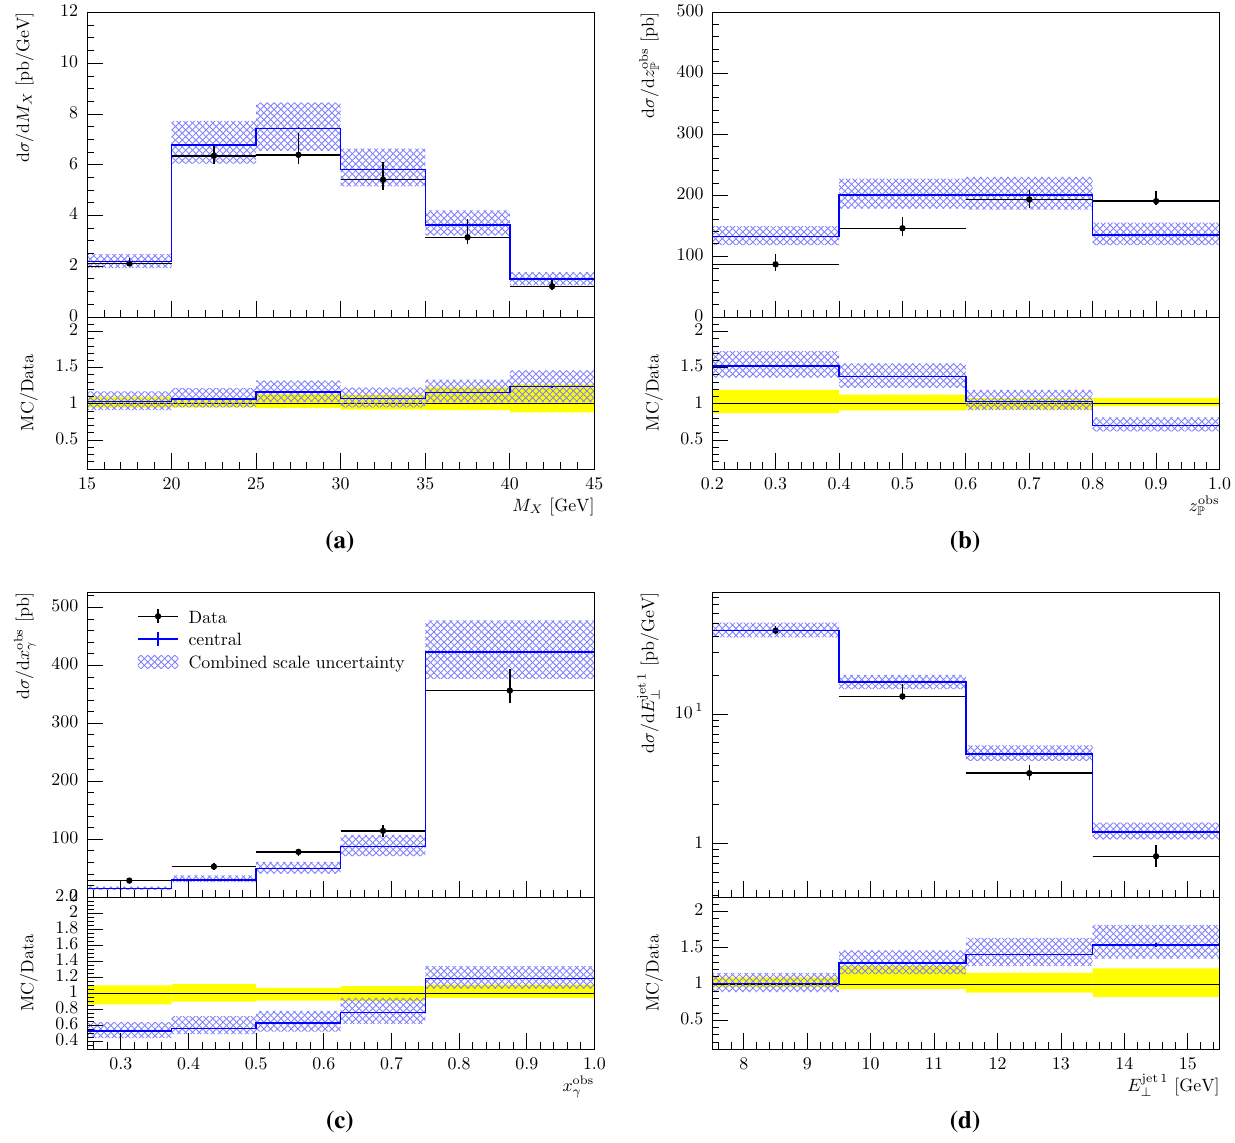
Fig. 9 The model along with the uncertainty bands arising from varying the renormalization- and factorization scales compared to ZEUS data on M X ( a ), z obs P ( b ), x obs γ ( c ) and E jet1 ⊥ ( d